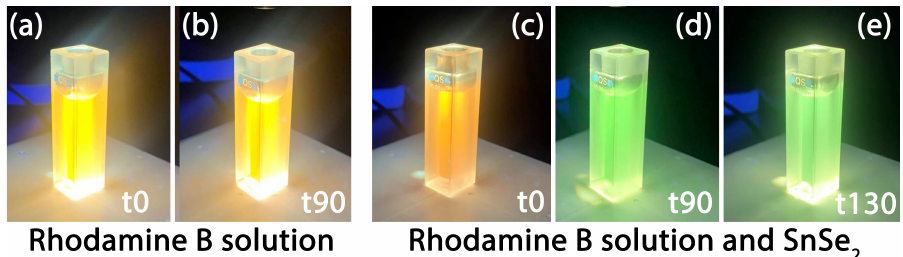
Figure 8. Optical images of RhB aqueous solutions ( a , b ) and RhB solution containing dispersed SnSe 2 flakes ( c – e ) at different UV illumination times, t0 (before exposition), t90 (90 min), and t130 (130 min).